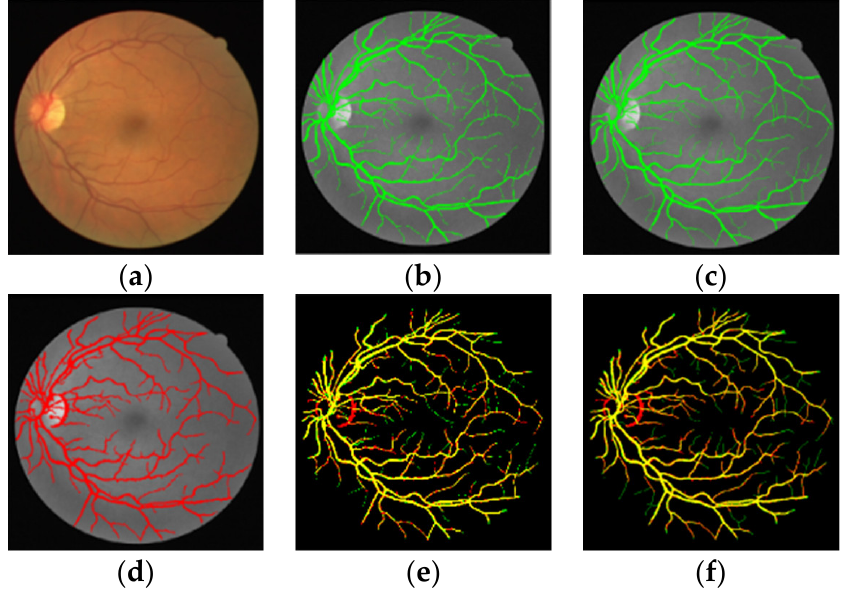
Figure 6. Comparison results of the proposed algorithm with that of experts on DRIVE 01_test. ( a ) DRIVE image; ( b ) Expert 1 segmentation result; ( c ) Expert 2 segmentation result; ( d ) Segmentation results of the proposed method; ( e ) Difference between segmentation result of proposed method and expert 1 segmentation result; ( f ) Difference between segmentation result of proposed method and expert 2 segmentation result.